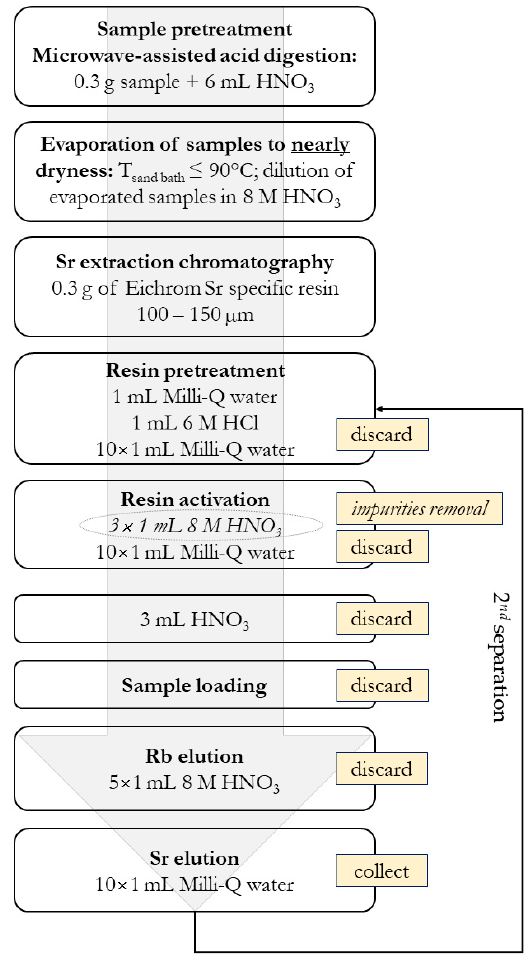
Figure 2. Analytical protocol for effective Sr isolation from the sample matrix.